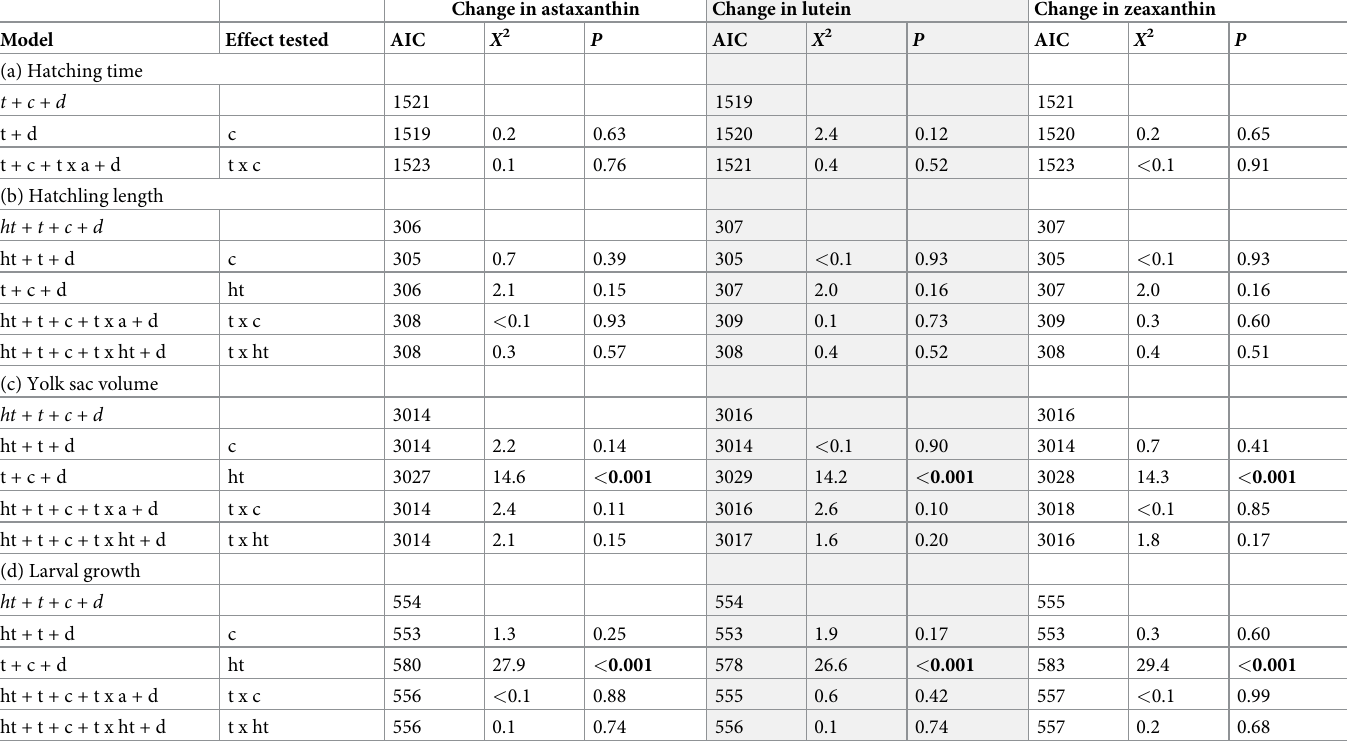
Table 3. The effects of treatment, proportional change in carotenoid contents on (a) hatching time, (b) hatchling length, (c) yolk sac volume at hatching, and (d) larval growth.